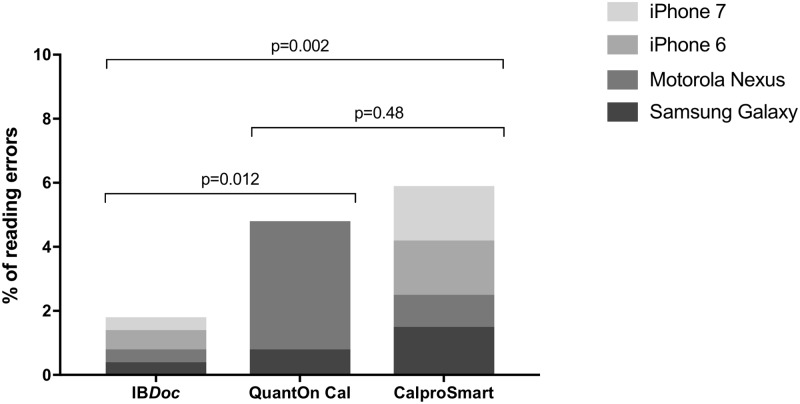
Reading error rate per home test for different smartphone types.